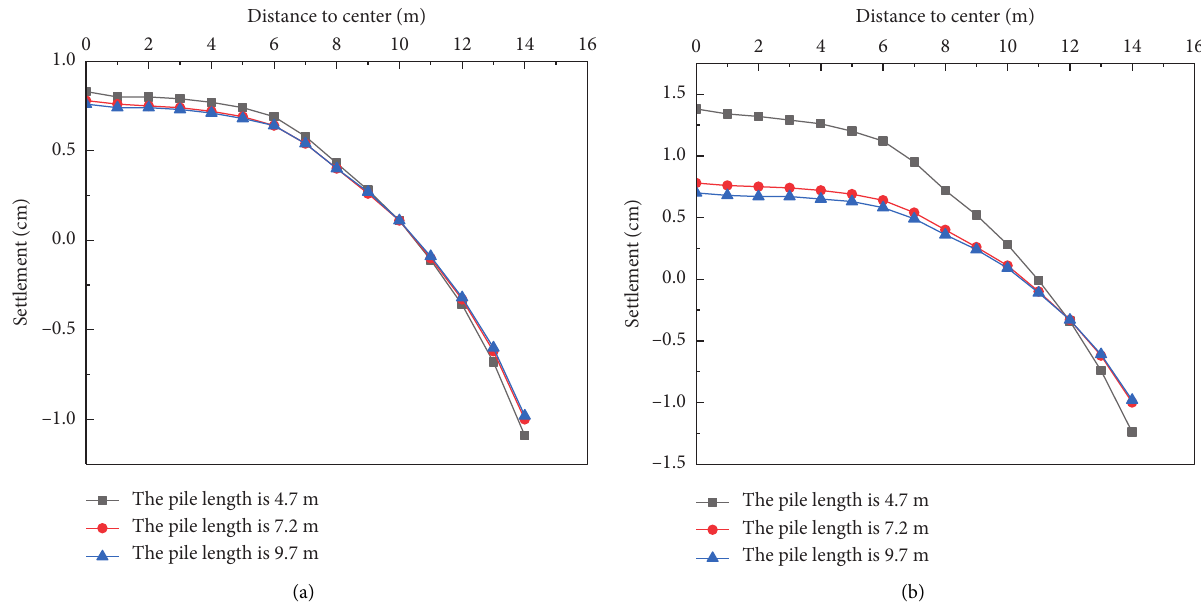
Figure 13: Settlement diagram of old subgrade surface completed under different piles lengths. (a) Varying pile length under the existing road slope. (b) Varying pile length under existing subgrade and new